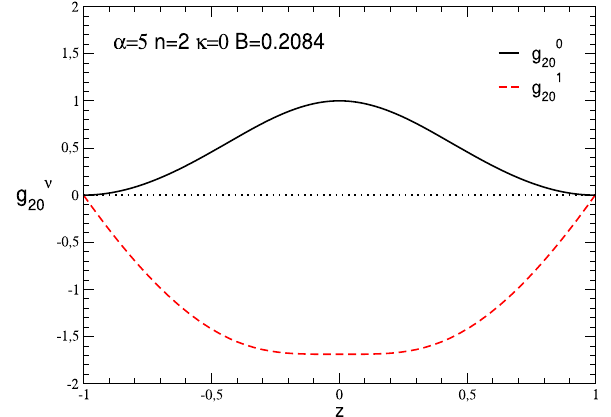
and g 1 of the normal state No. 2 from Table 20 20